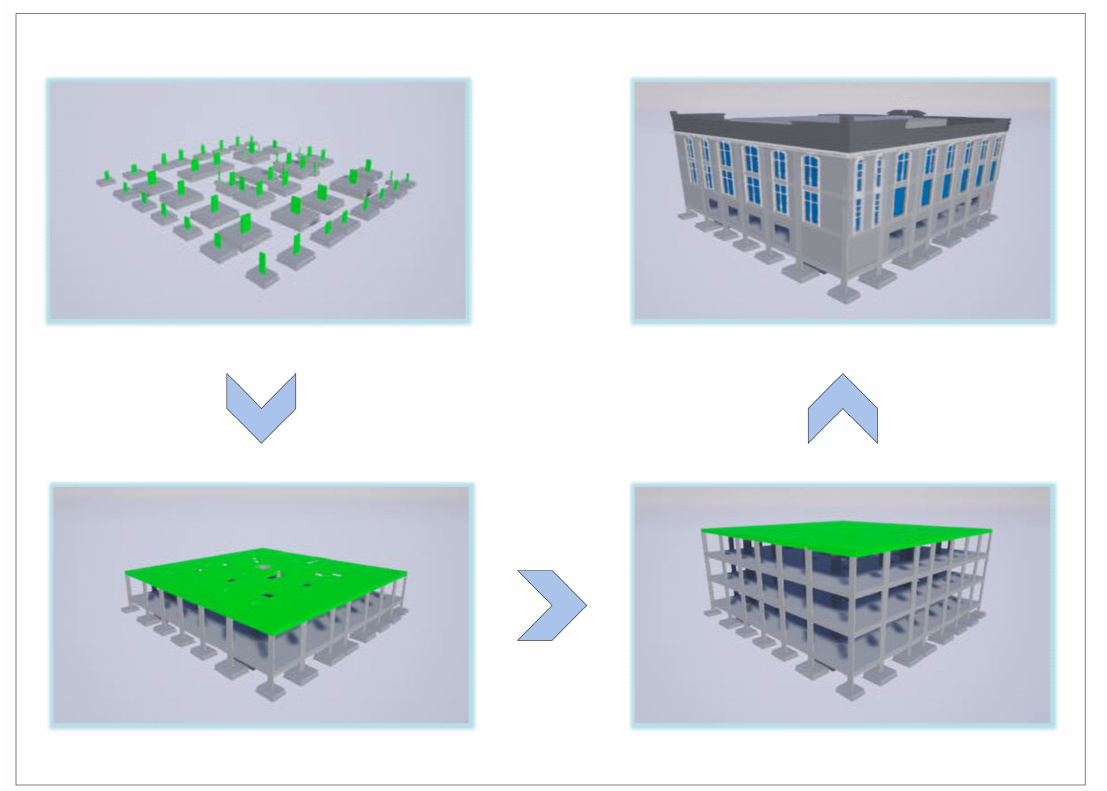
Figure 6. Synchro simulation.